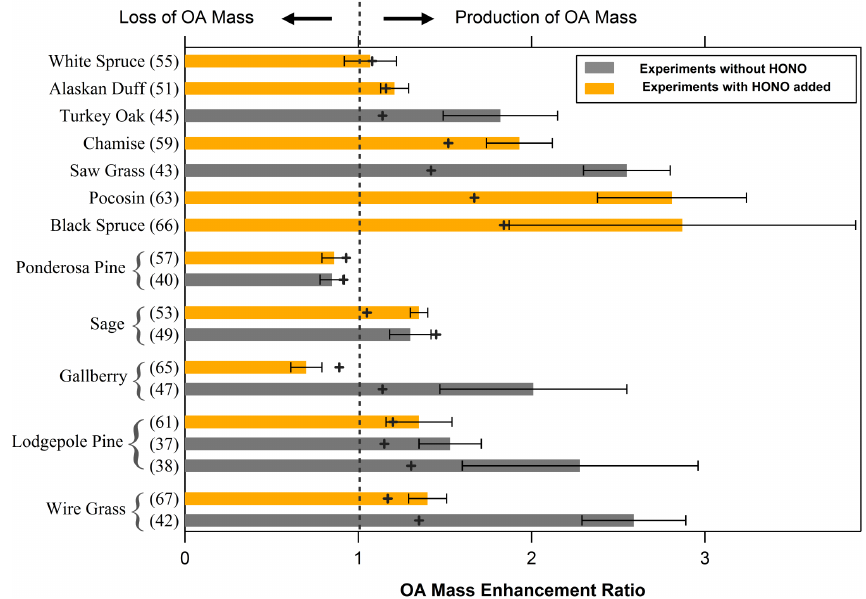
Fig. 3. Organic aerosol mass enhancement ratios measured at the end of the photo-oxidation phase of each experiment (labeled by fuel name, with burn number in parenthesis). Gray color indicates experiments with no HONO addition while orange color indicates experiments where HONO was added to increase OH levels (see Table 2). Error bars (values given in Table 2) represent measurement uncertainty and differences in OA mass enhancement ratios calculated using the BC ratio method and direct wall-loss estimate (Sect. 2.2). Black crosses represent OA mass enhancement ratios according to the ω = 0 estimate (Sects. 2.2 and